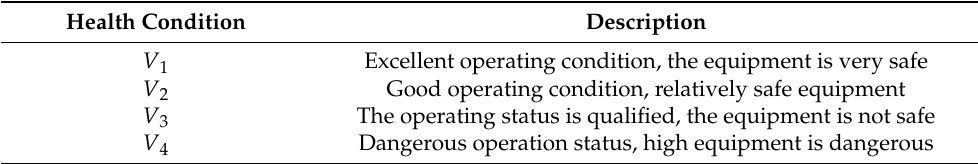
Table 1. Description of each